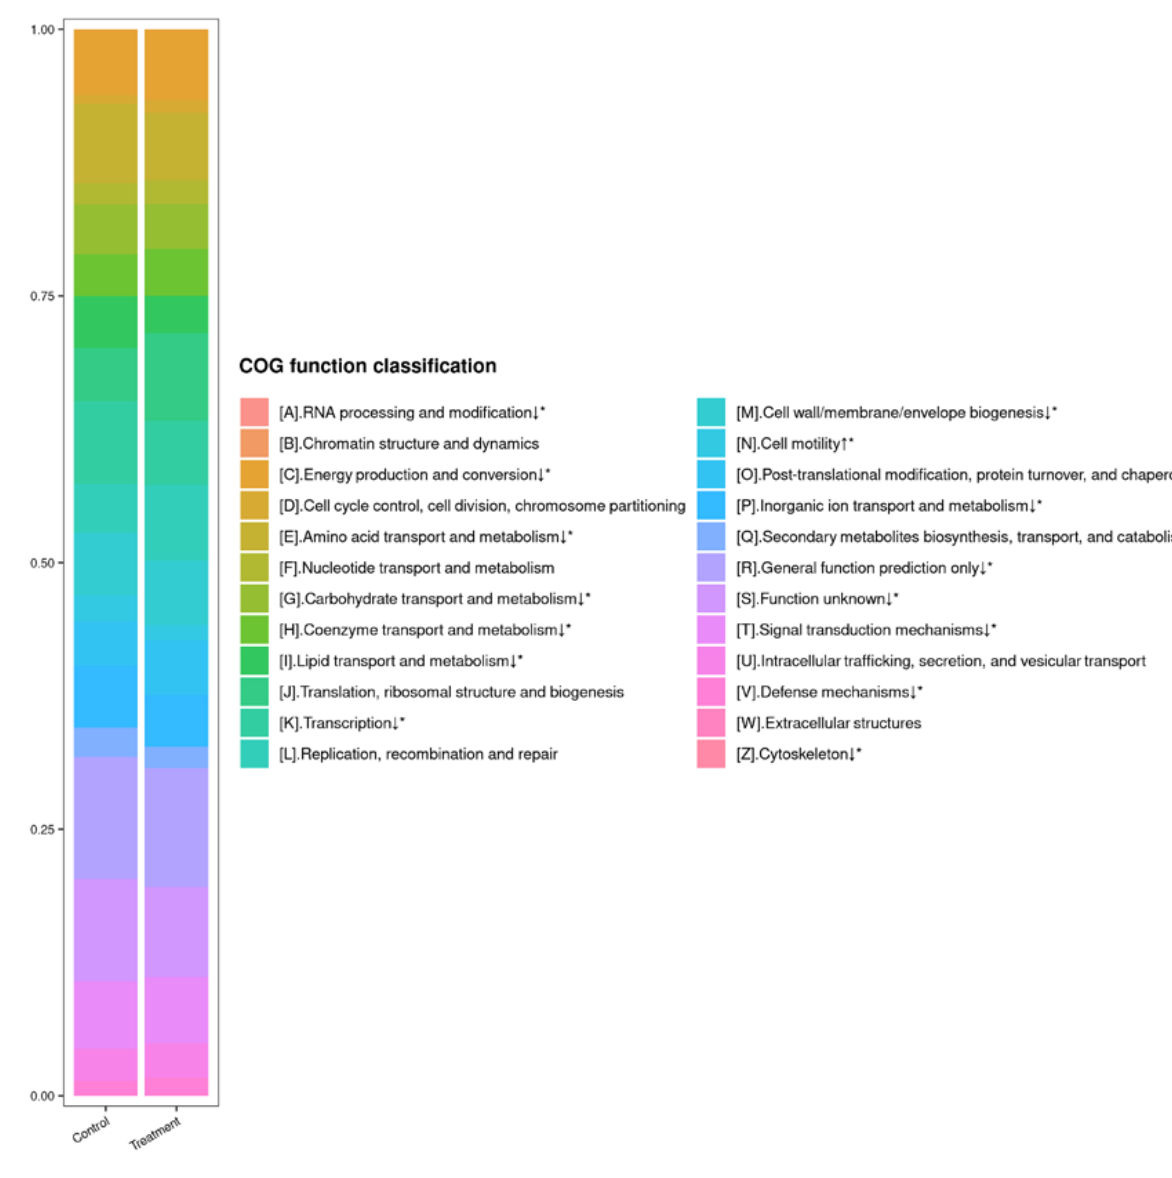
Figure 5. Summary of PICRUSt analysis. Asterisk indicates a significant difference in the relative abundances of the gut microbial communities ( n = 4; independent samples t -test; *, p <